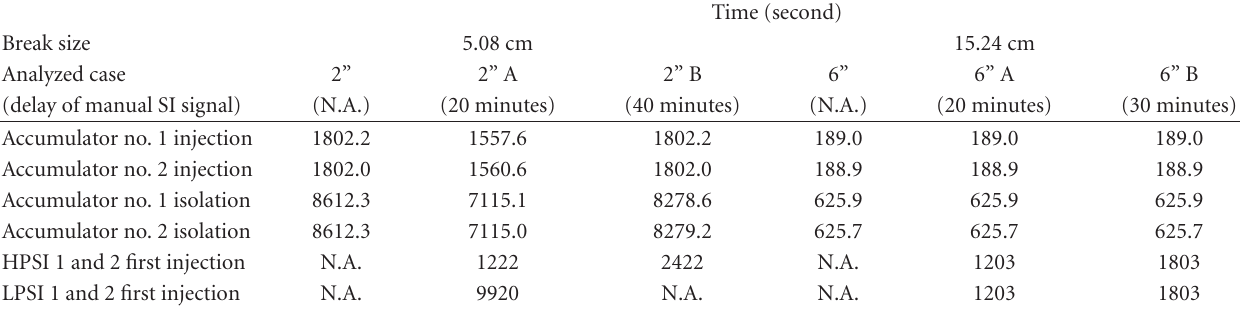
Table 6: Coolant injection times for LOCA calculations with/without SI